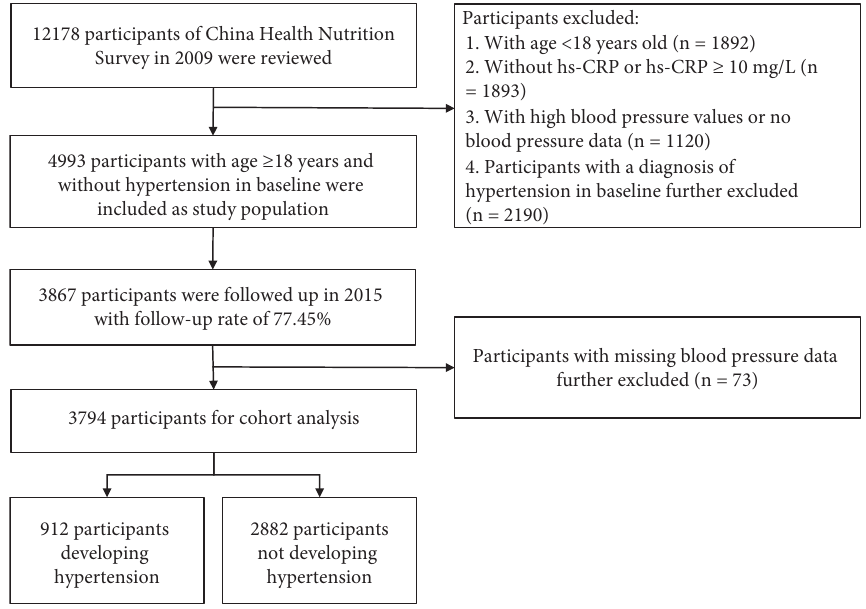
Figure 1: Participant